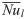
Effect of volume fraction φ of nanoparticles on Nu¯l for different types of porous media and porosities.